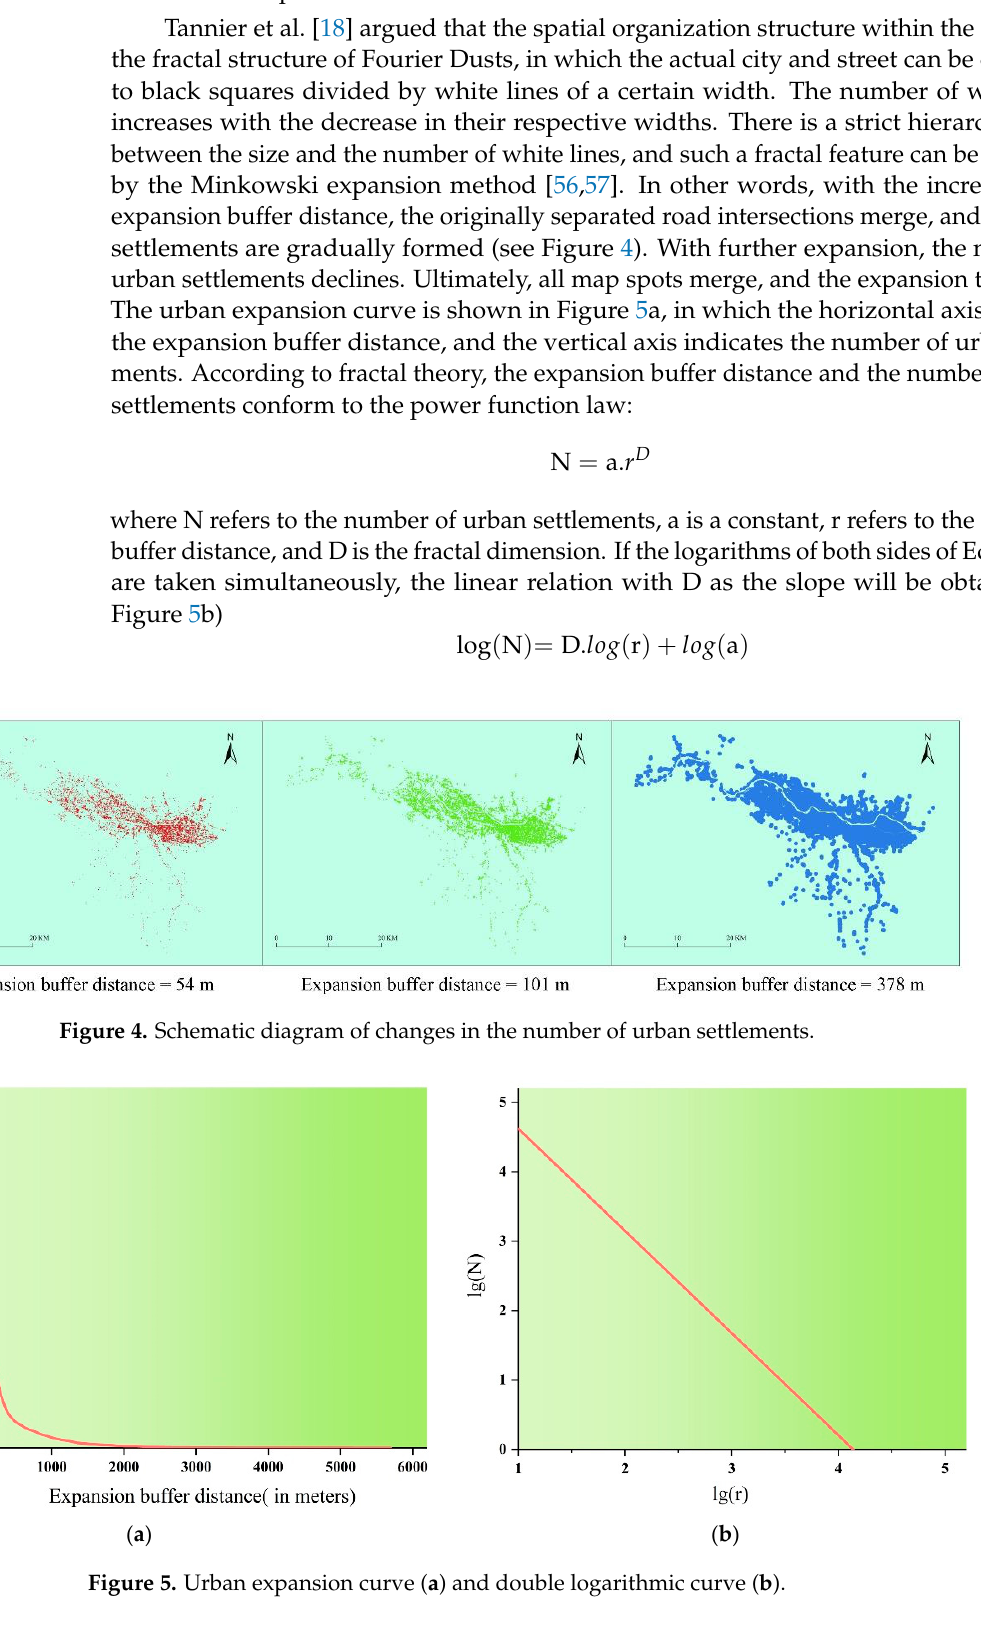
Figure 5. Urban expansion curve ( a ) and double logarithmic curve ( b ).